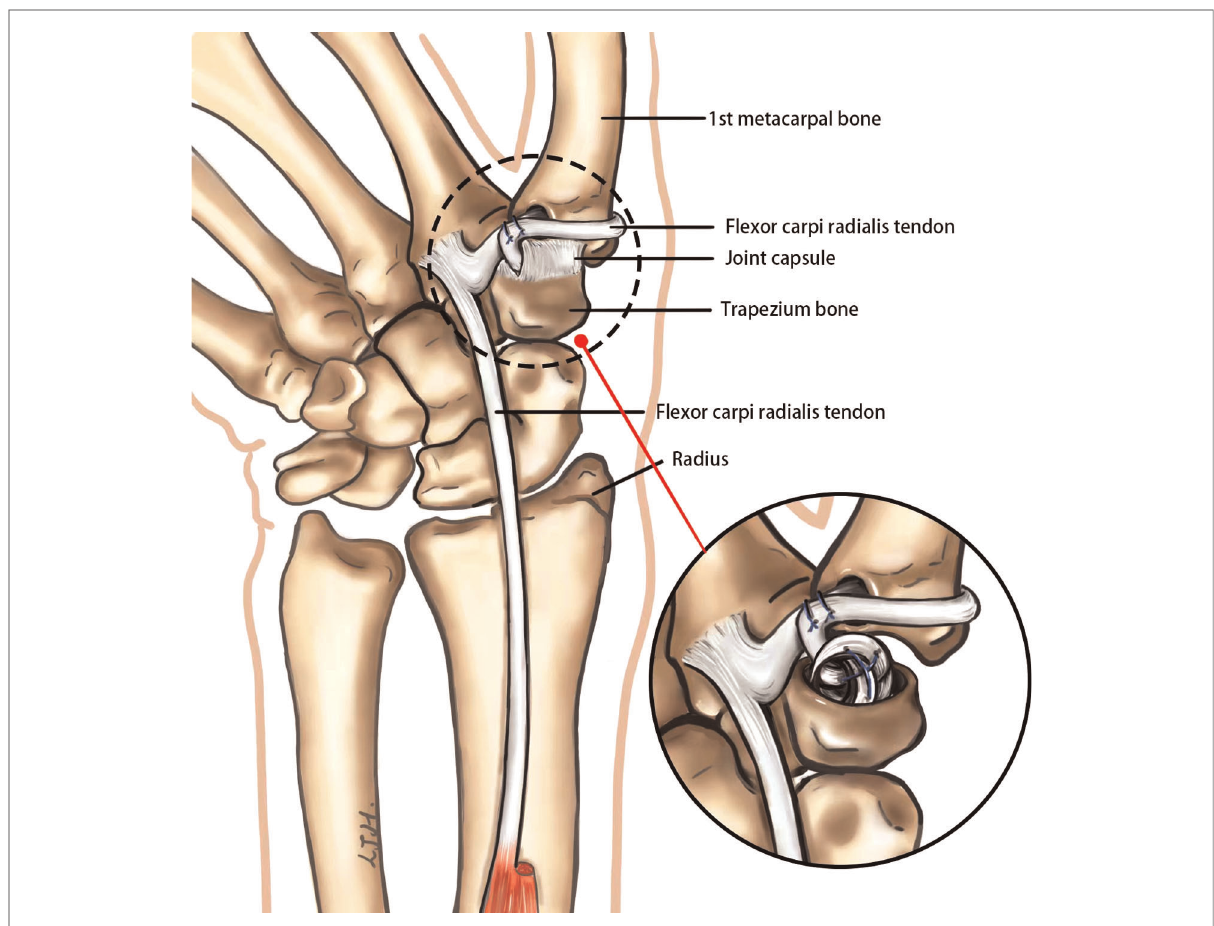
FIGURE 4 Ligament reconstruction. Surrounding the base of fi rst metacarpal, one half of the tendon passes from the volar side to the dorsal side through the transosseous tunnel in fi rst metacarpal and sutures with itself on the volar